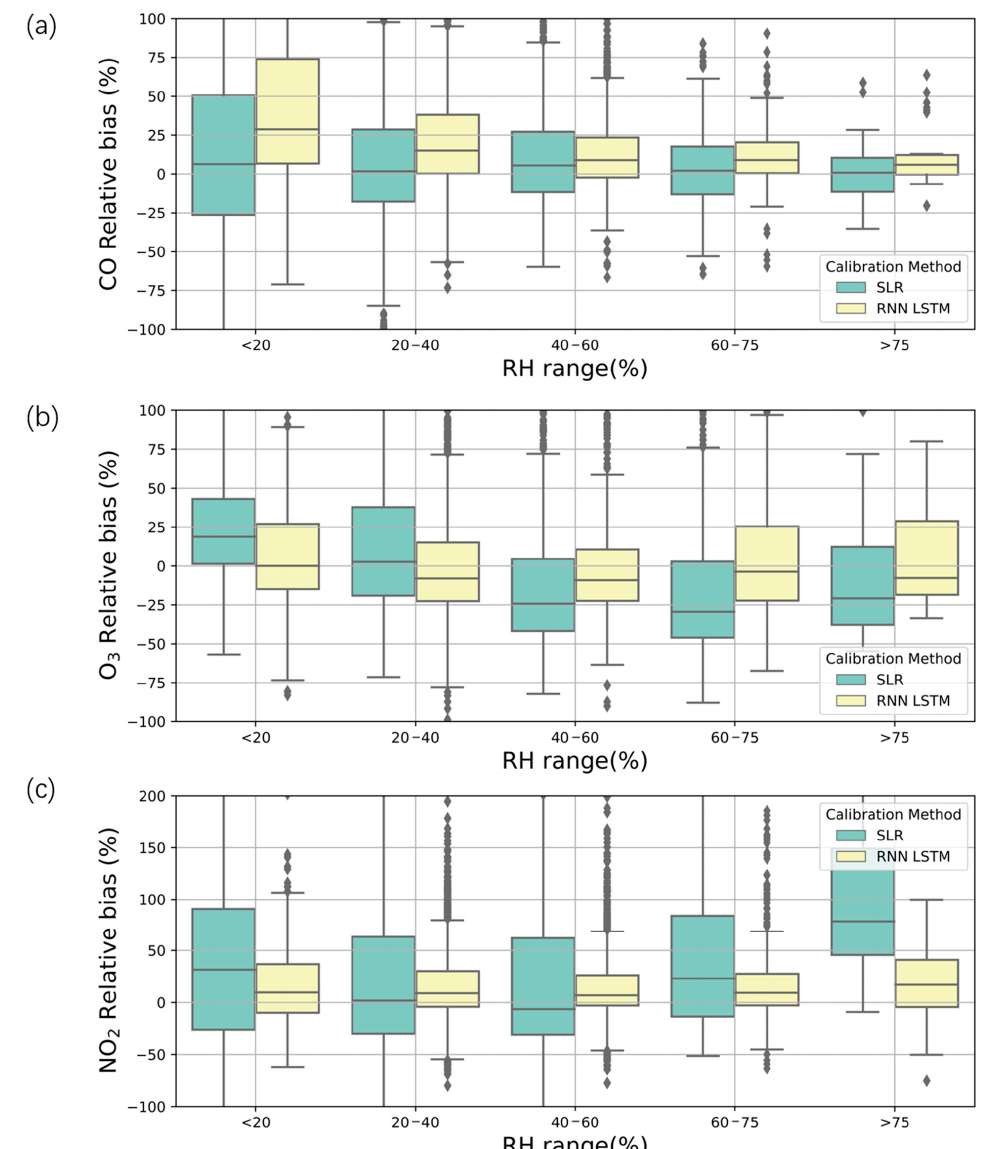
Figure 7. Comparison of the relative biases between the calibrated sensors and MEE at different relative humidity (RH) ranges. ( a ) CO, ( b ) O 3 , and ( c ) NO 2